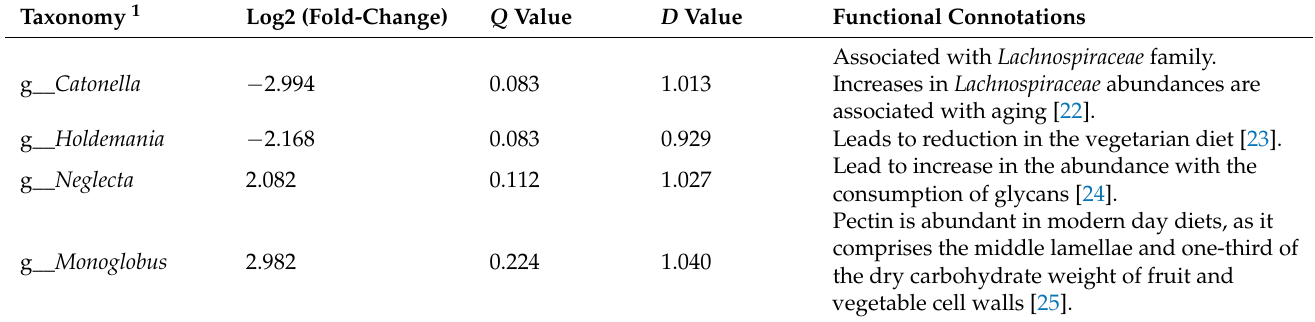
Figure 3. Stacked plots ( A ) and area charts ( B ) presenting diversity of the species for the subjects not resistant to UV irradiation following grape consumption ( n = 20) on Days 15, 30 and 60. Subjects are listed by number in Table 1. Table 2. Comparison of the taxonomy of Day 15 vs. Day 30 for subjects resistant to UV irradiation following grape consumption ( n =